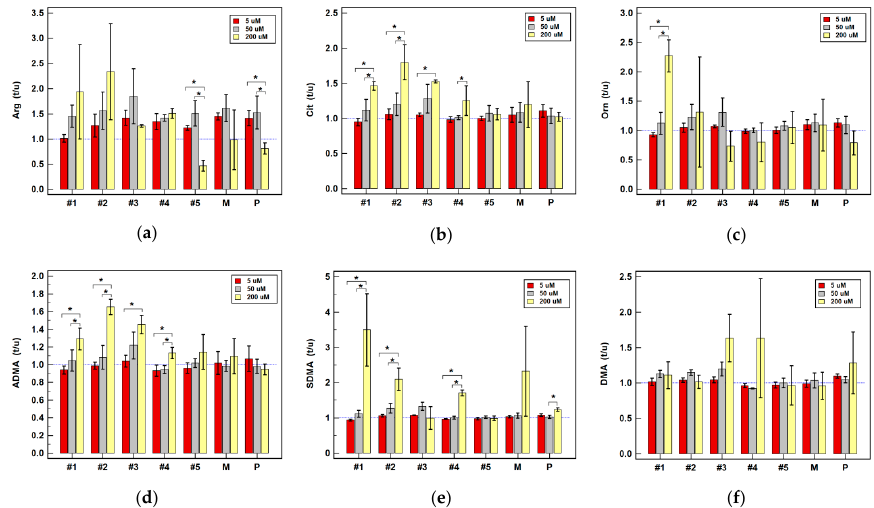
Figure 8. Dose-dependent effect of oxicams on the intracellular metabolite concentration in Caco-2 cells stimulated with 5, 50 and 200 µM drug concentrations for 24 h: ( a ) Arginine (Arg); ( b ) Citrulline (Cit); ( c ) Ornithine (Orn); ( d ) Asymmetric dimethylarginine (ADMA); ( e ) Symmetric dimethylarginine (SDMA); ( f ) Dimethylamine (DMA). Bars represent mean ( n = 3) concentration ratios treated-to-untreated cells (t/u) with standard deviation (whiskers). No effect is marked by horizontal blue reference line. Data were analyzed using one-way analysis of variance. * significant between-group differences; #1–5, oxicam analogues; M, meloxicam; P, piroxicam.